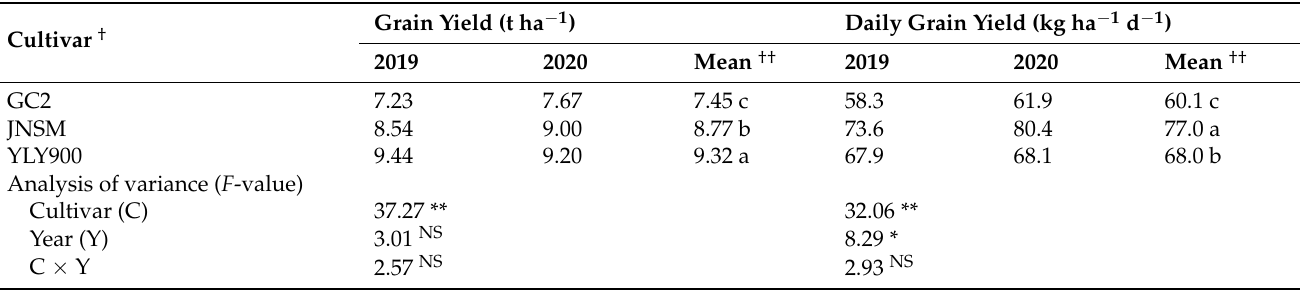
Table 2. Grain yield and daily grain yield of three rice cultivars grown in 2019 and